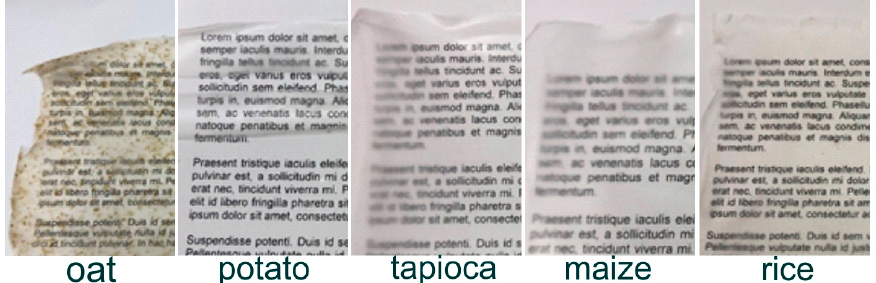
Figure 1. The appearance of various starch films.